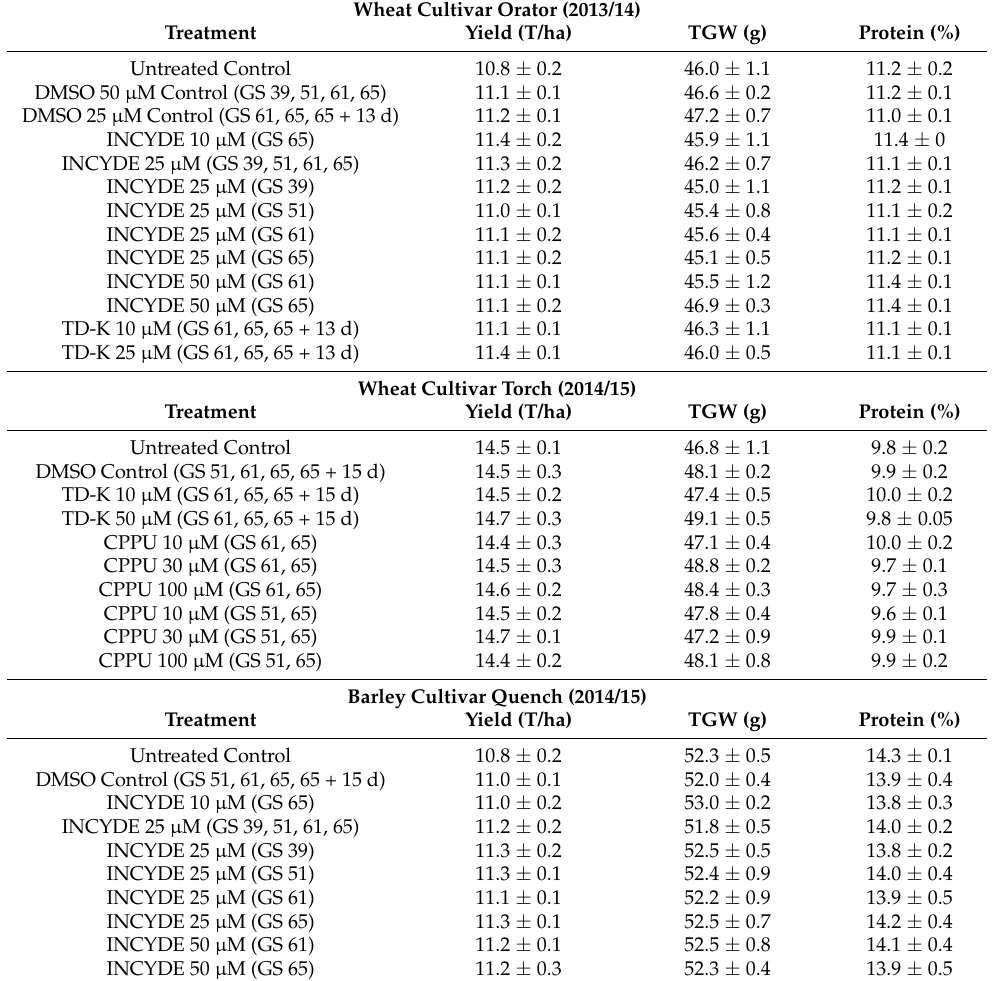
Table 1. Yield and protein composition in wheat (cv. Orator and cv. Torch) and barley (cv. Quench). Wheat Cultivar Orator (2013/14)